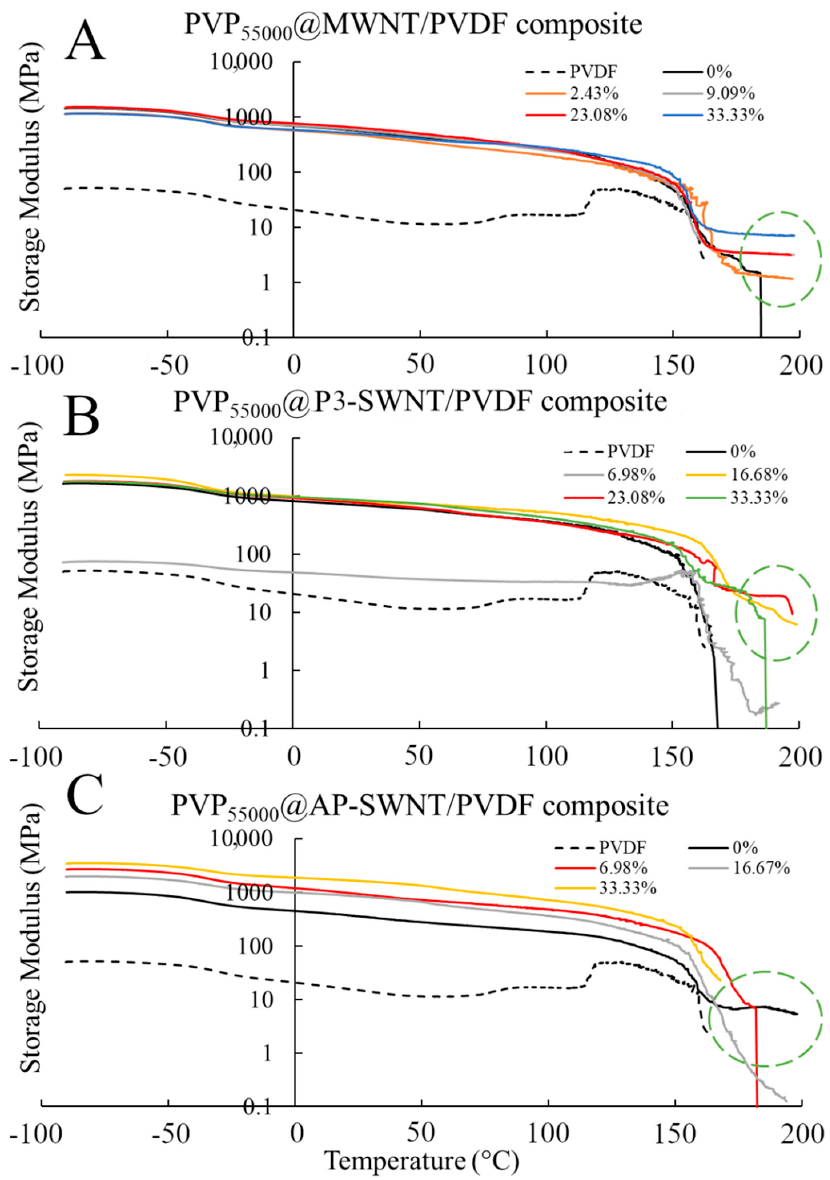
Figure 6. Storage Modulus of PVP 55000 functionalized MWNT ( A ); P3-SWNT ( B ); and AP-SWNT ( C ) in PVDF